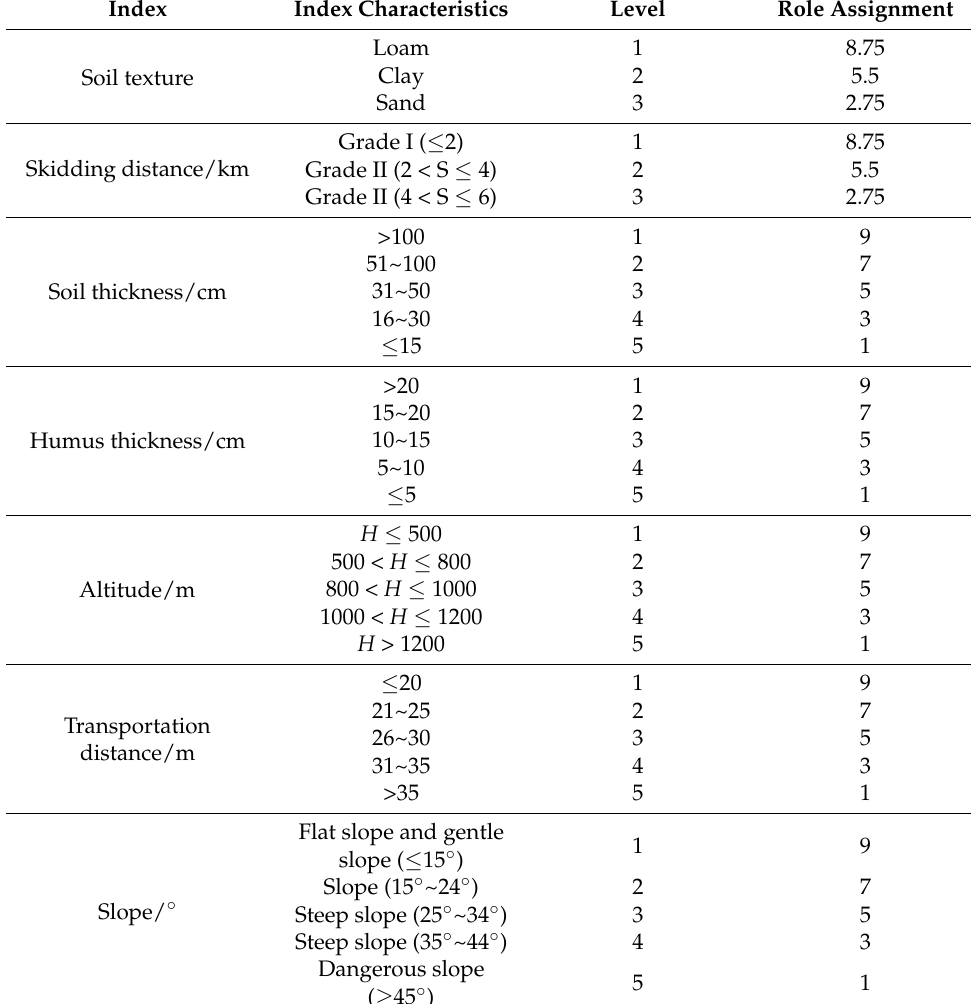
Table 2. Assignment of indicator